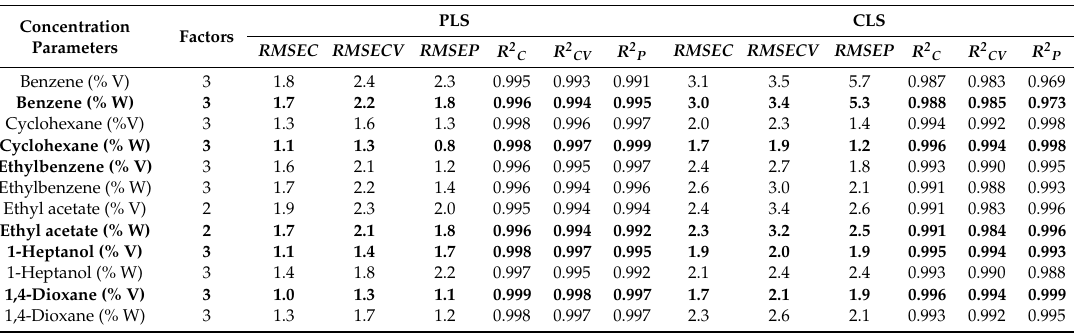
Table 2. The calibration and test results obtained with PLS and CLS regressions of the Raman spectra of system 1 and system 2 based on %V and %W concentrations (the bold values highlight the higher-quality results with reference to the concentration